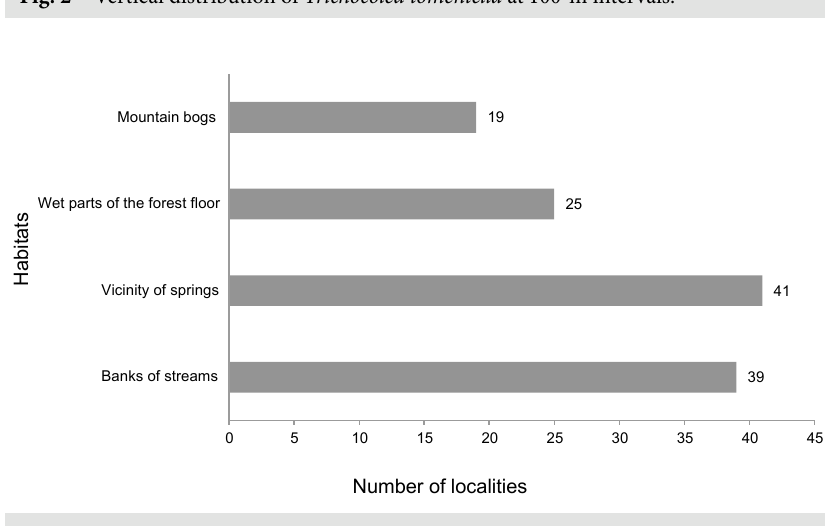
Fig. 2 Vertical distribution of Trichocolea tomentella at 100-m intervals.